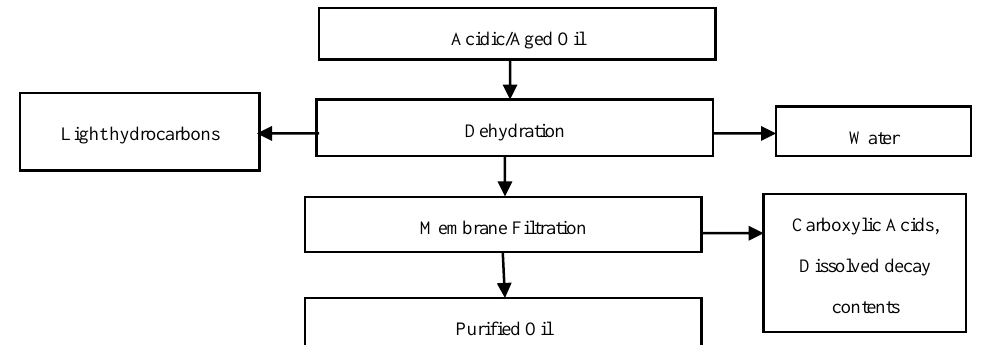
Figure 2. Illustration of the proposed oil filtration method.